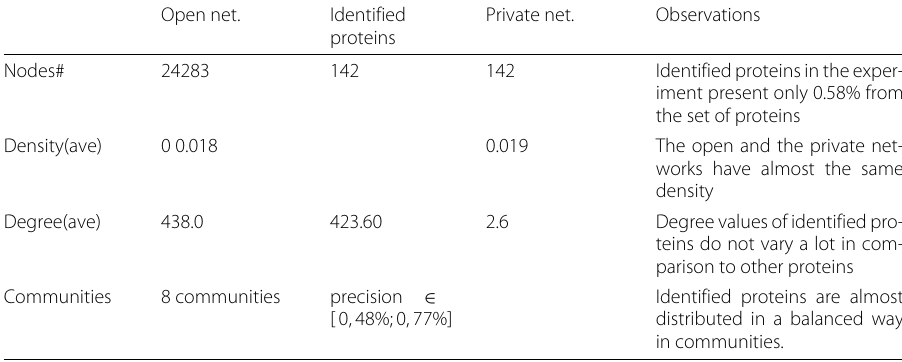
Table 5 Proteins layer analysis: summary of results for the minimum combing score Open